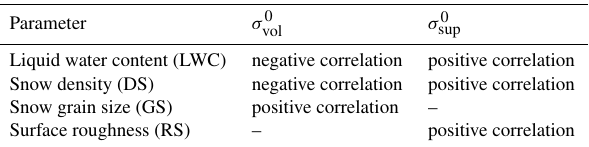
Table 1. Simplified SAR backscattering response to wet snow di- vided in volumetric, σ 0 , and surface backscattering, σ 0 sup , contri- vol butions. Considering a sufficiently thick snowpack the contribution of σ 0 can be grd